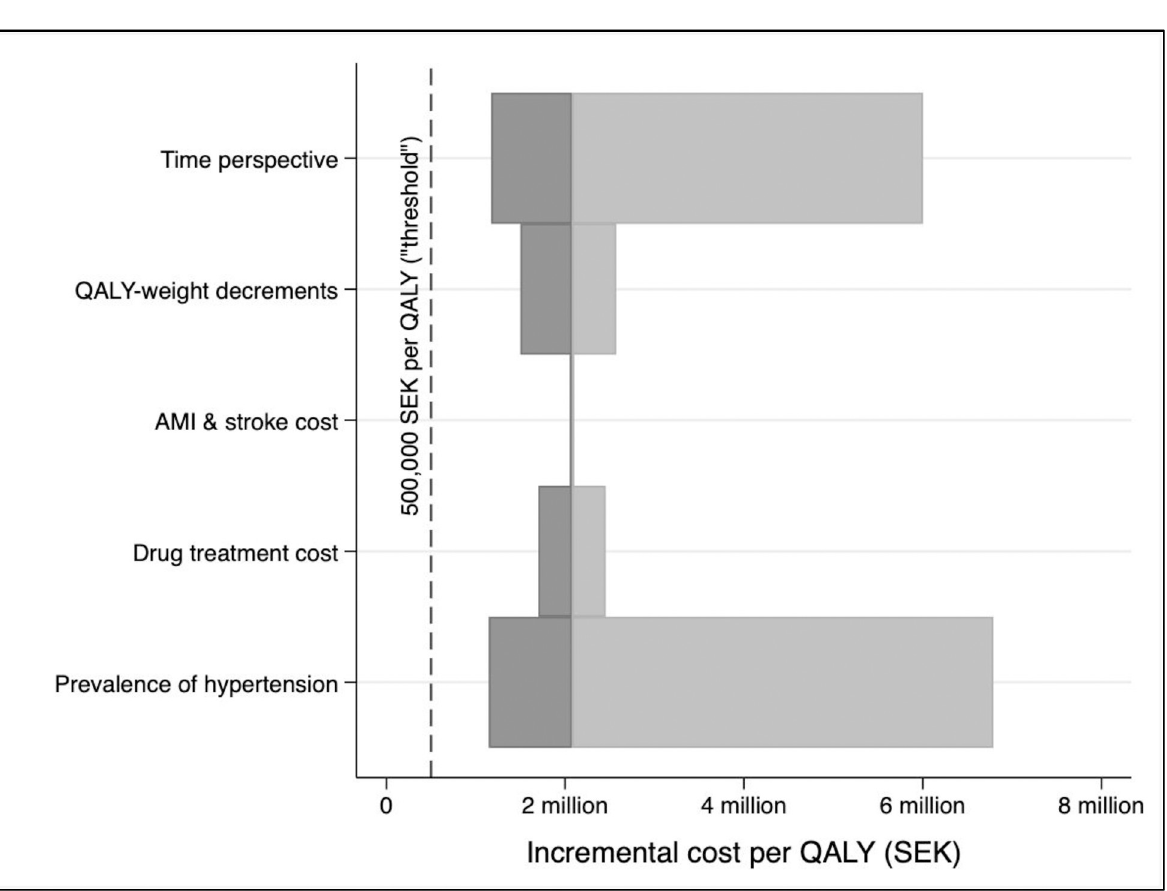
Fig 2. One-way (deterministic) sensitivity analysis: Tornado diagram. Notes: Input parameter values are varied one at a time (higher/lower) by 20% from the base-case assumptions and the ICER is then re-calculated in each case, except for the time-perspective, which varies 50% (higher/ lower) compared to the base-case scenario. The bars show the lowest/highest ICER that is the result from each change in the input parameter values.